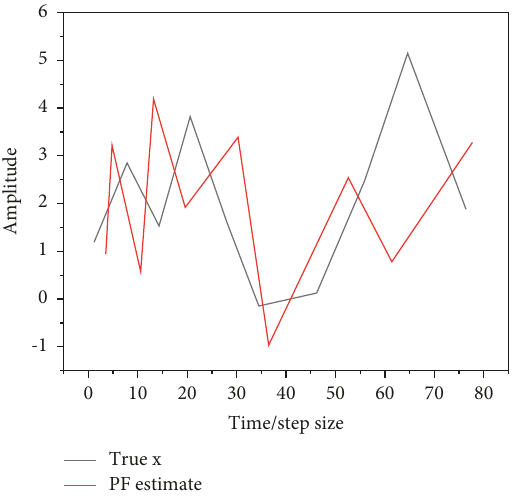
Figure 4: Design scheme